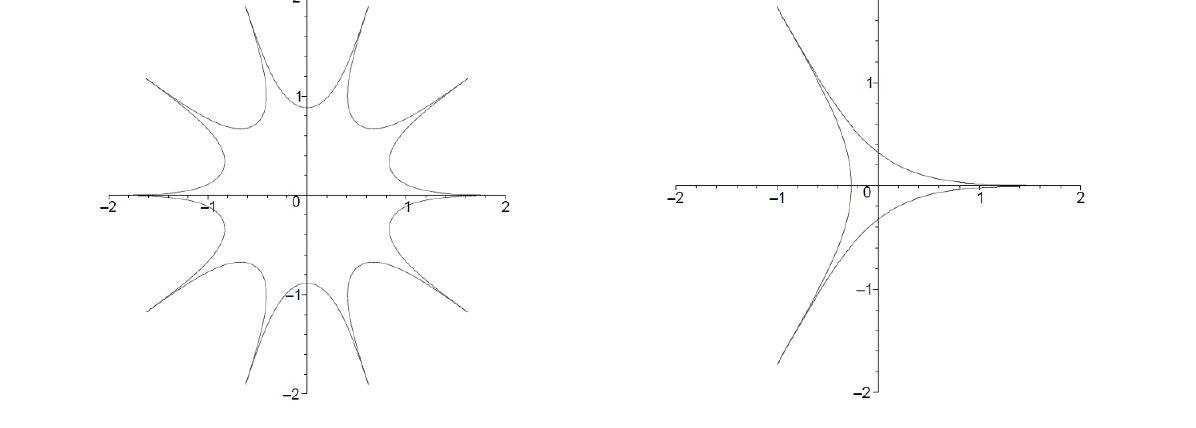
Figure 1. The Kruczenski spiky string in ( (cid:26); (cid:18) ) plane for n = 10 spikes with (cid:26) 1 = 2 : 0 & (cid:26) 0 = 0 : 88266.